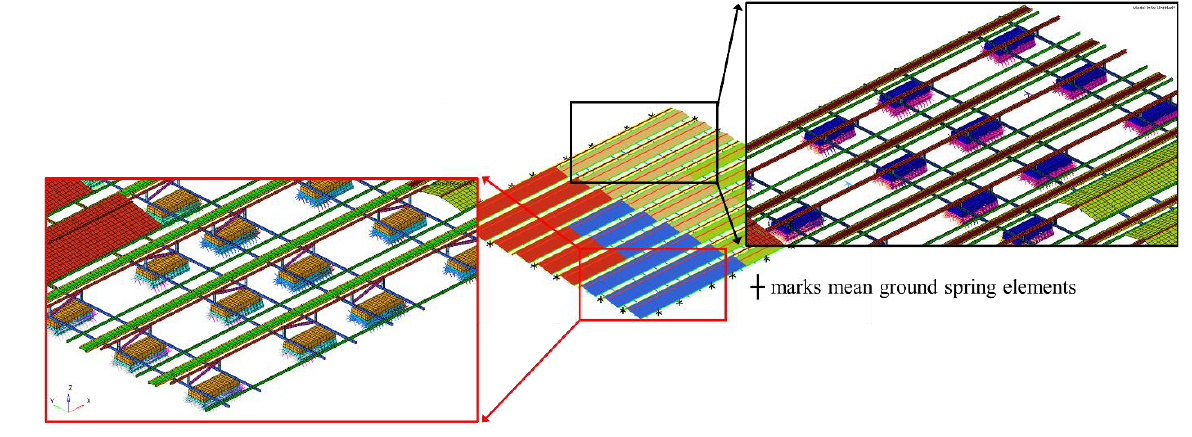
Figure 7. Structural analysis model. Table 6. Material information for structure analysis.